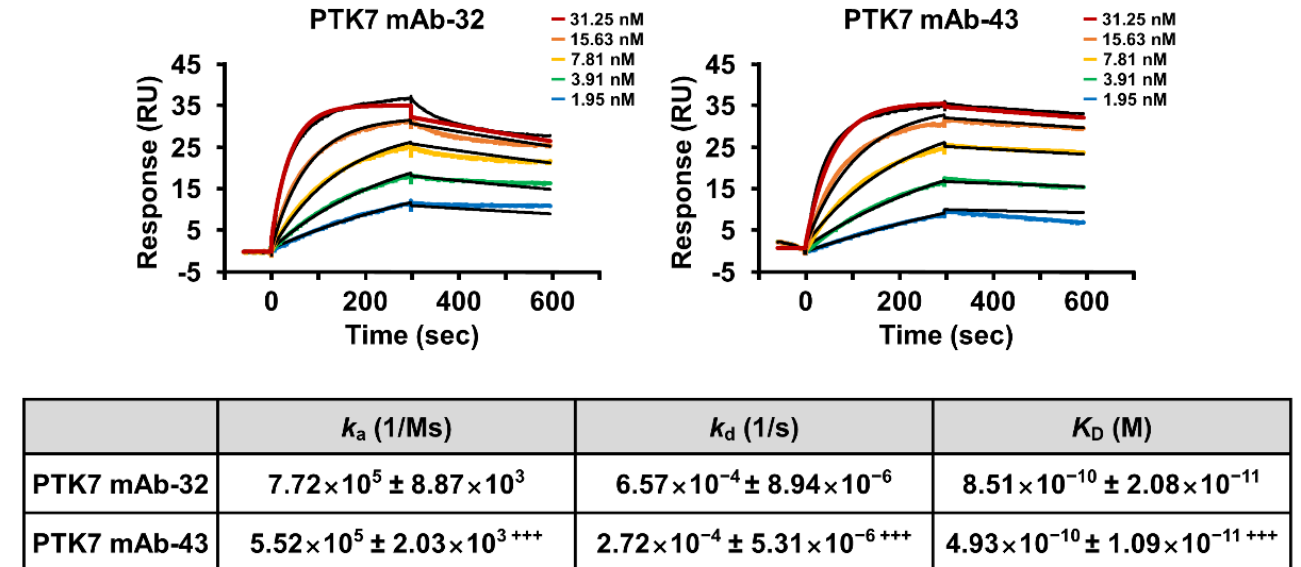
Figure 1. PTK7 mAbs bind to sPTK7 with high affinity. The binding affinities of PTK7 mAb-32 and PTK7 mAb-43 were measured using SPR analysis. The His-tagged sPTK7 polypeptide was immobilized on a sensor chip as a ligand and increasing concentrations of PTK7 mAbs were injected into the sensor chip chamber. The measured kinetic constants are presented in a table below the sensograms. Each value in the inserted table represents the mean ± SD of three independent experiments: +++ p < 0.001 vs. PTK7 mAb-32.